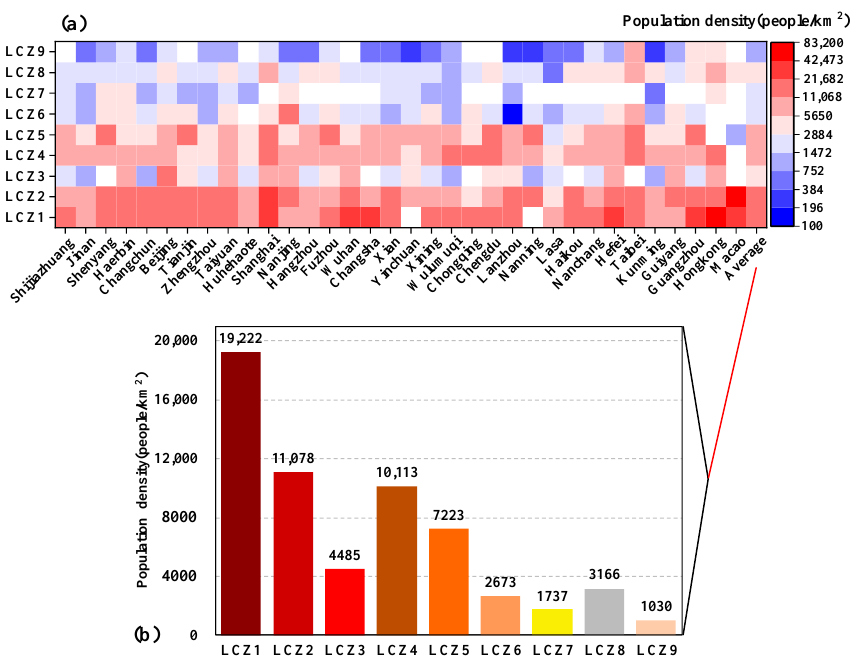
Figure 10. ( a ) Heat map of population density at the LCZ scale for 34 cities. ( b ) Histogram of average population density for each LCZ.